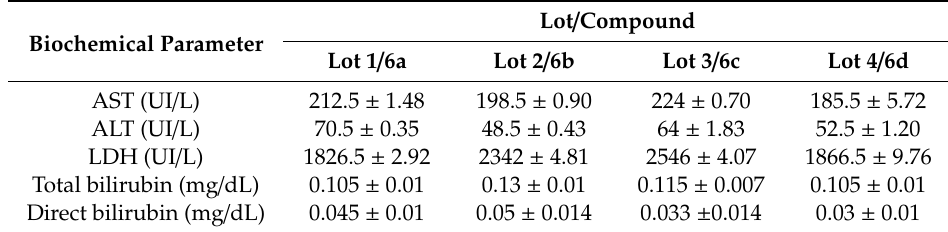
Table 6. Values of the liver function parameters in rats from groups 6e, 6f, FA and Diclofenac sodium. Biochemical Parameter